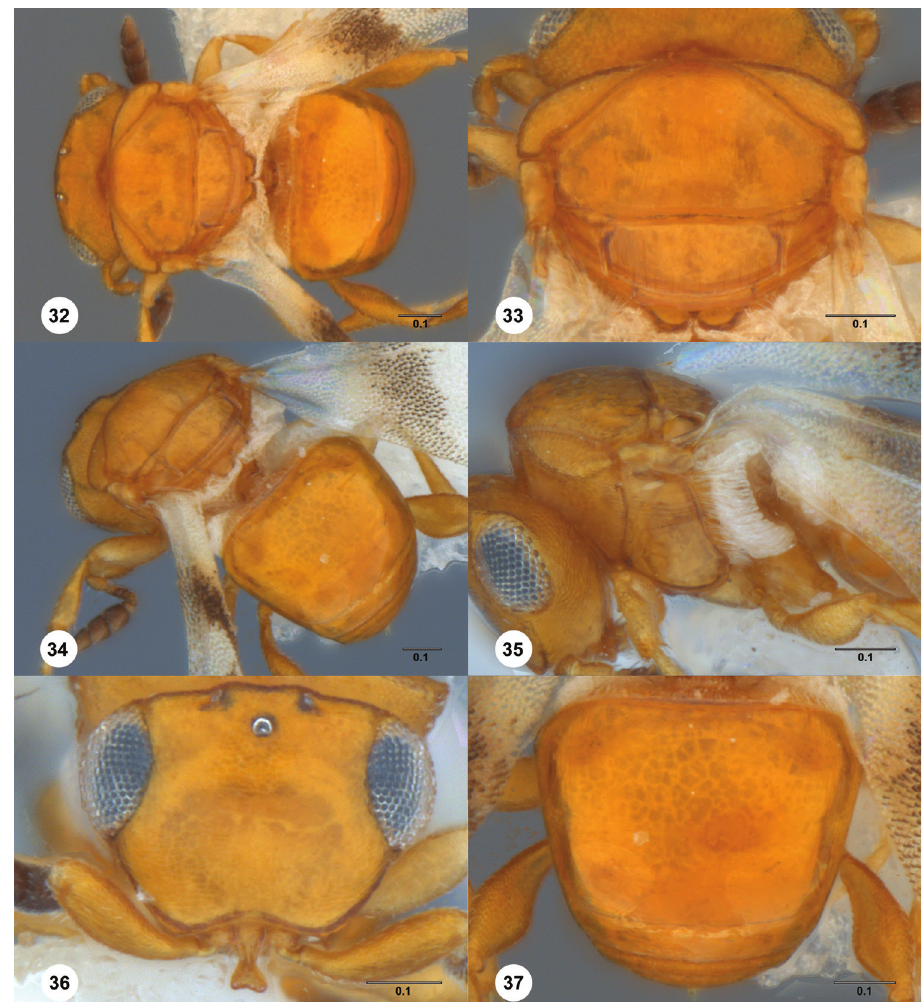
dorsal view 33 mesosoma, dorsal view 34 head, mesosoma, metasoma, posterodorsal view 35 mesosoma, lateral view 36 head, anterior view 37 metasoma, dorsal view. Scale bars in